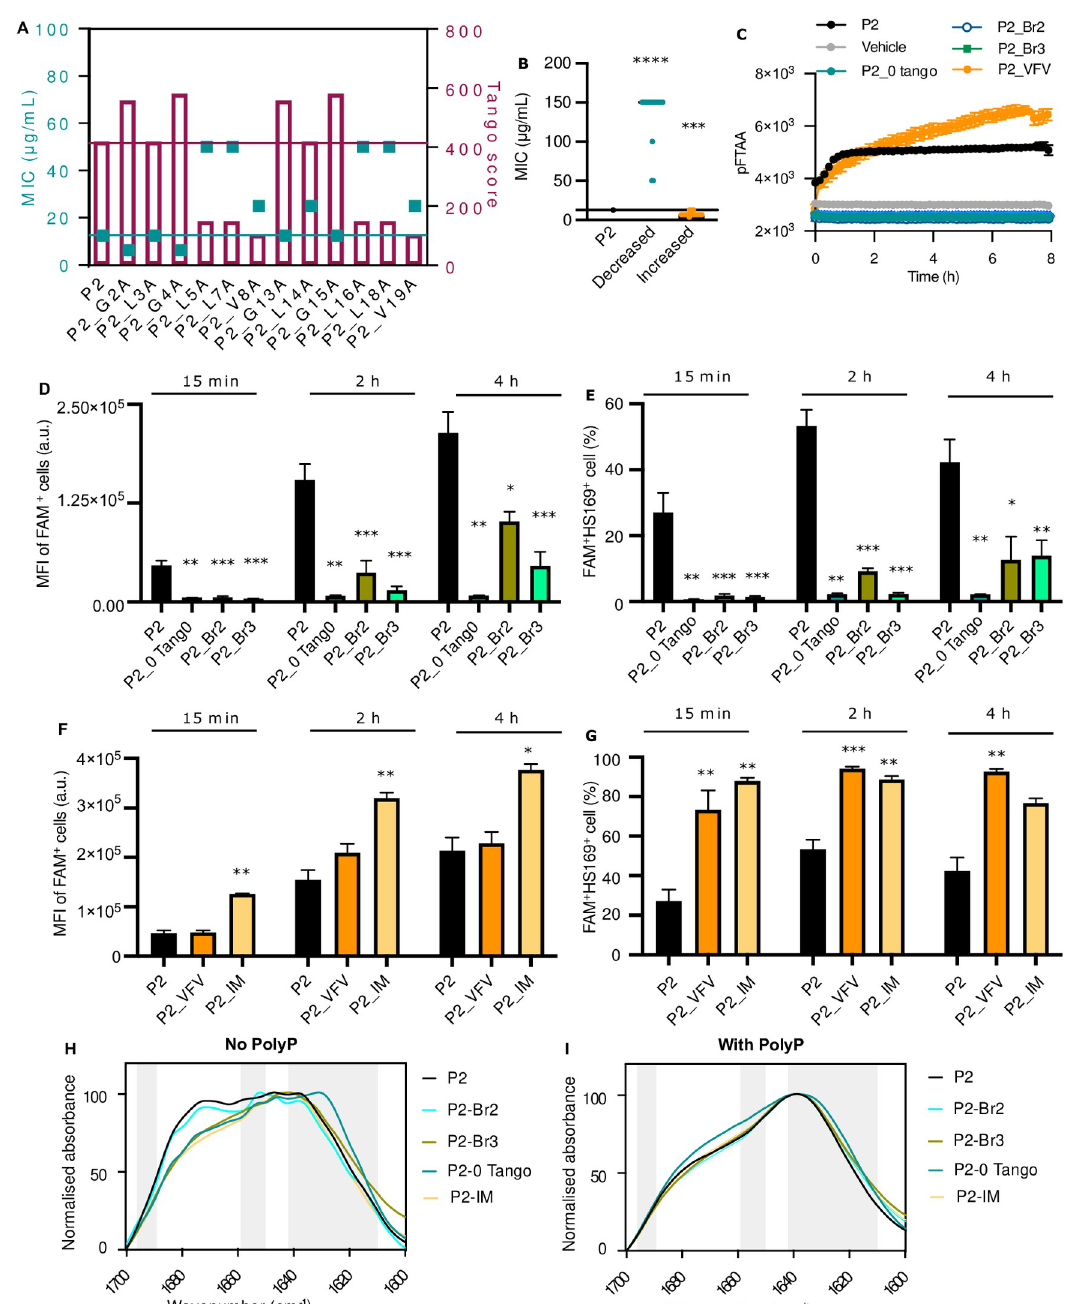
Fig 2. Increased aggregation propensity enhances Pept-in antimicrobial potency by promoting Pept-in accumulation and IB formation. A: MIC (left Y-axis) against E . coli BL21 and Tango score (right Y-axis) of P2 derivatives generated by alanine scanning of the APR region. This figure is associated with data from S3 Table. The red bars represent the APR TANGO score, and the red line is the baseline of the P2 APR Tango score. The blue squares represent MIC values, and the blue line is the baseline of P2 MIC. B : MIC of P2 variants generated by aggregation propensity modification against E . coli BL21. This figure is associated with data from S5 Table. Each dot represents the MIC of one Pept-in design. C-G: P2 variants with decreased aggregation propensity: P2_0 Tango, P2_Br2, P2_Br_3; with increased aggregation propensity: P2_VFV, P2_IM. C: Time dependence of pFTAA (0.5 μ M) fluorescence intensity of P2 derivatives (50 μ M) in the presence of polyP (0.5 mM) (n = at least 6). D-G: Flow cytometry analysis of E . coli BL21 treated with FAM-labelled Pept-ins for different time points at FAM-P2-MIC from three independent experiments. Samples were acquired using Gallios Flow Cytometry. MFI of FAM + cells ( D ), and the percentage + of FAM and HS169 + cells ( E ) when treated with P2 and its derivatives with decreased antimicrobial potency. MFI of FAM + cells ( F ), and the percentage + of FAM and HS169 + cells